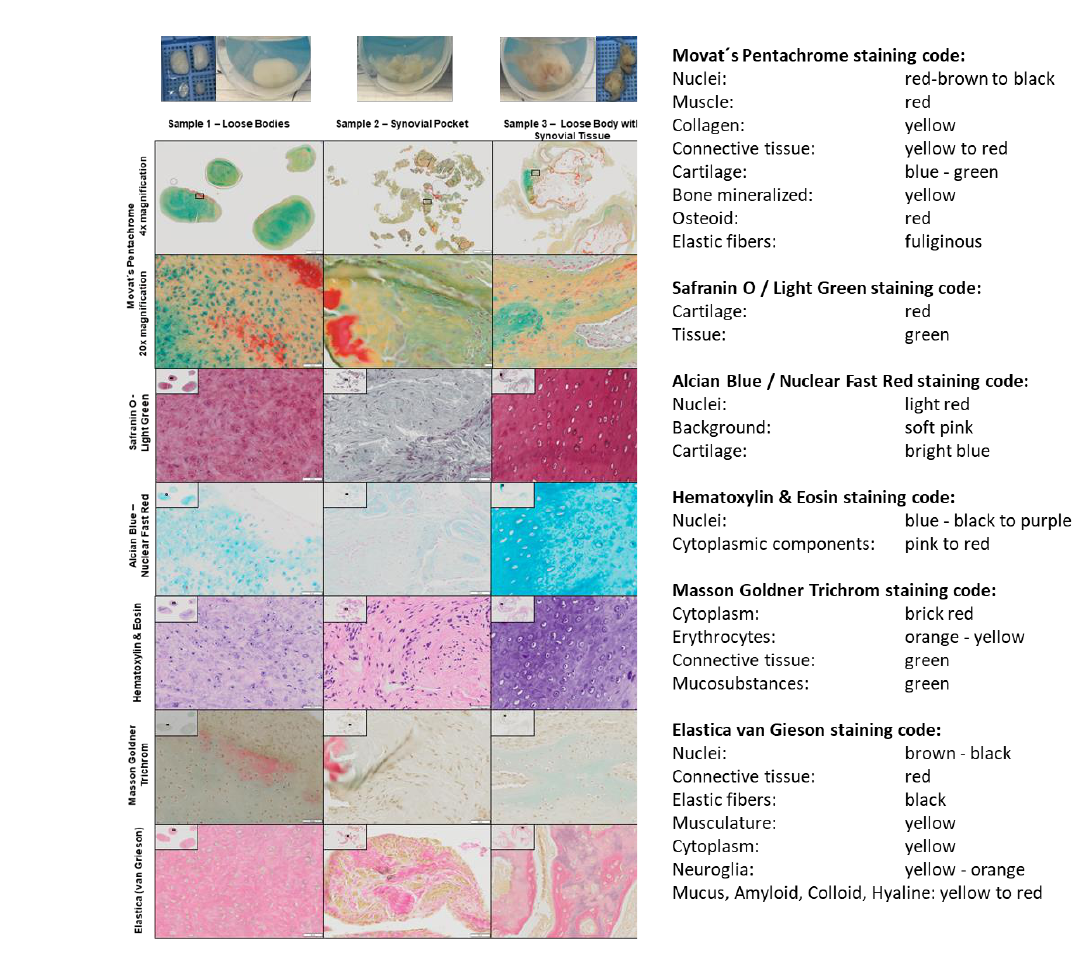
Figure A1. Histological overview of loose Bodies and synovial pocket. Exemplary patient samples and the corresponding stainings with color codes.